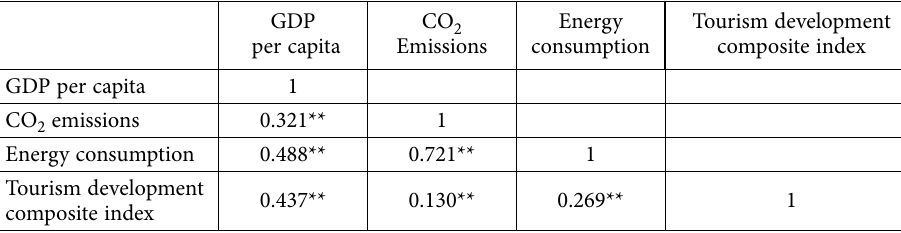
GDP CO 2 Energy Tourism development per capita Emissions consumption composite index